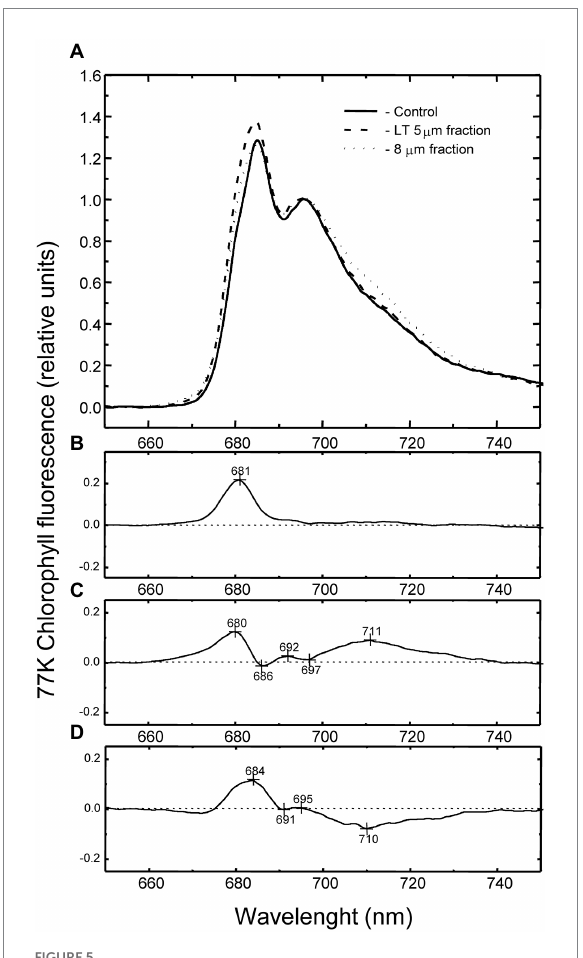
FIGURE 5 Low-temperature (77 K) chlorophyll fluorescence emission spectra of C. priscuii control cells (solid line), LT 5 μ m cell fraction (dashed line), and 8 μ m cell fraction (dotted line; A ). Chl fluorescence was excited at 436 nm. The spectra were normalized at 695 nm. Corresponding difference spectrum of LT 5 μ m cell fraction - control (B) 8 μ m cell fraction - control (C) and LT 5–8 μ m cell fraction (D)